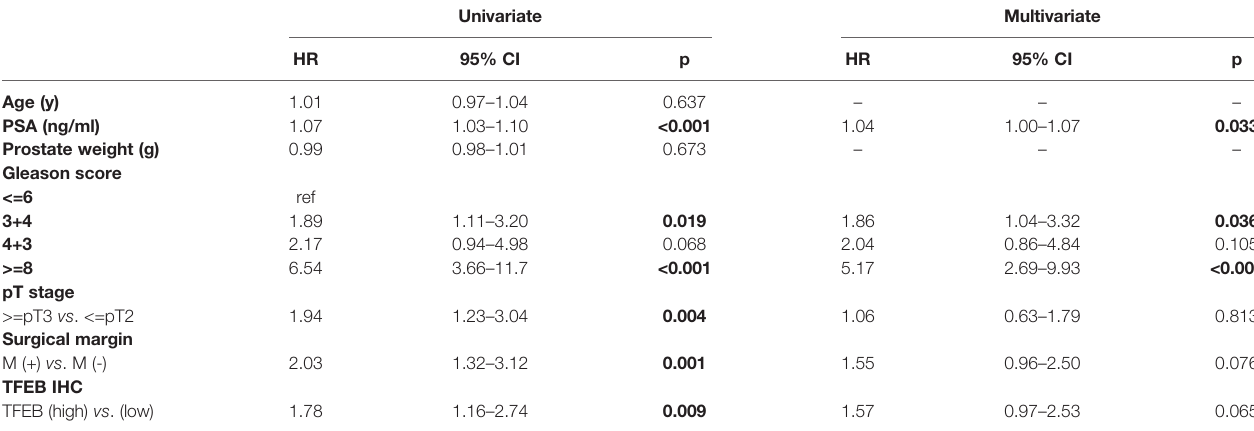
TABLE 2A | Univariate and multivariate analysis of clinicopathologic factors with biochemical recurrence-free survival. Multivariate Cox regression model fi tted with factors that showed signi fi cance in univariate analysis.